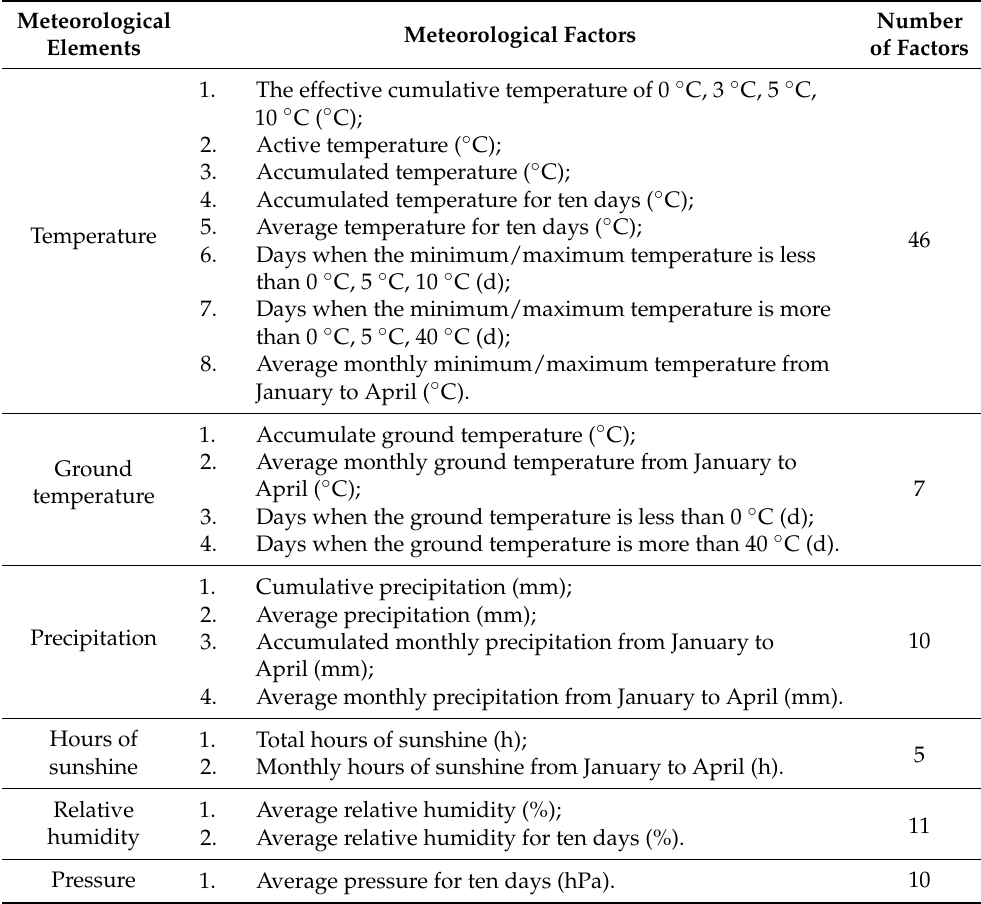
Table 1. Table of meteorological factors affecting the initial flowering of P. orientalis